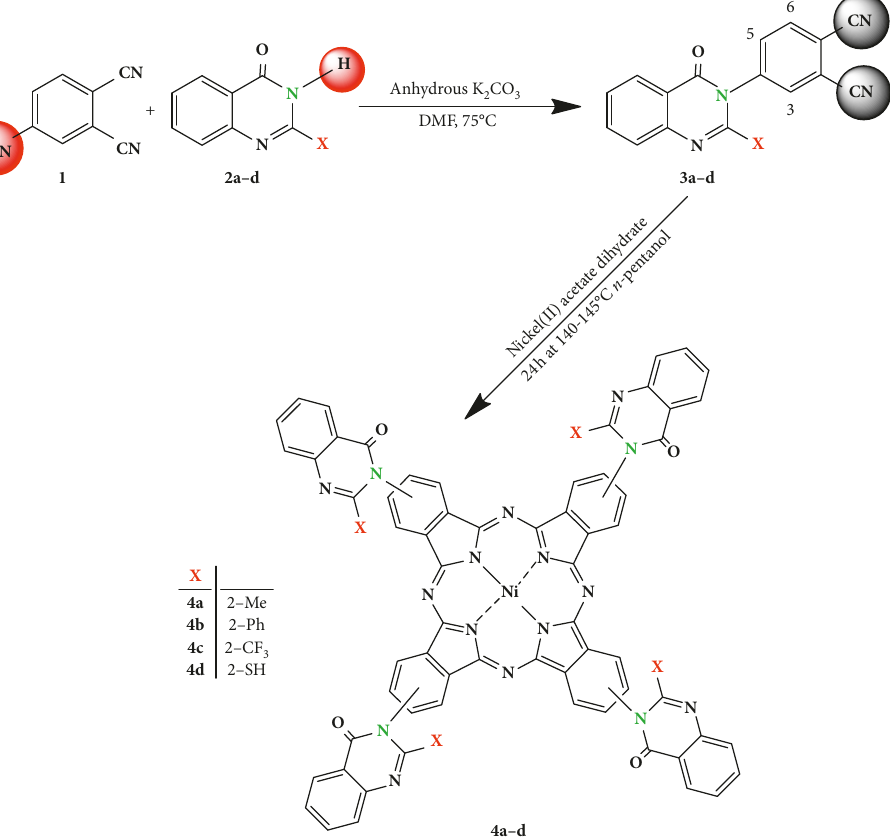
Figure 1: The synthetic pathway for the preparation of tetra quinazolinone nickel(II)phthalocyanine derivatives ( 4a–d